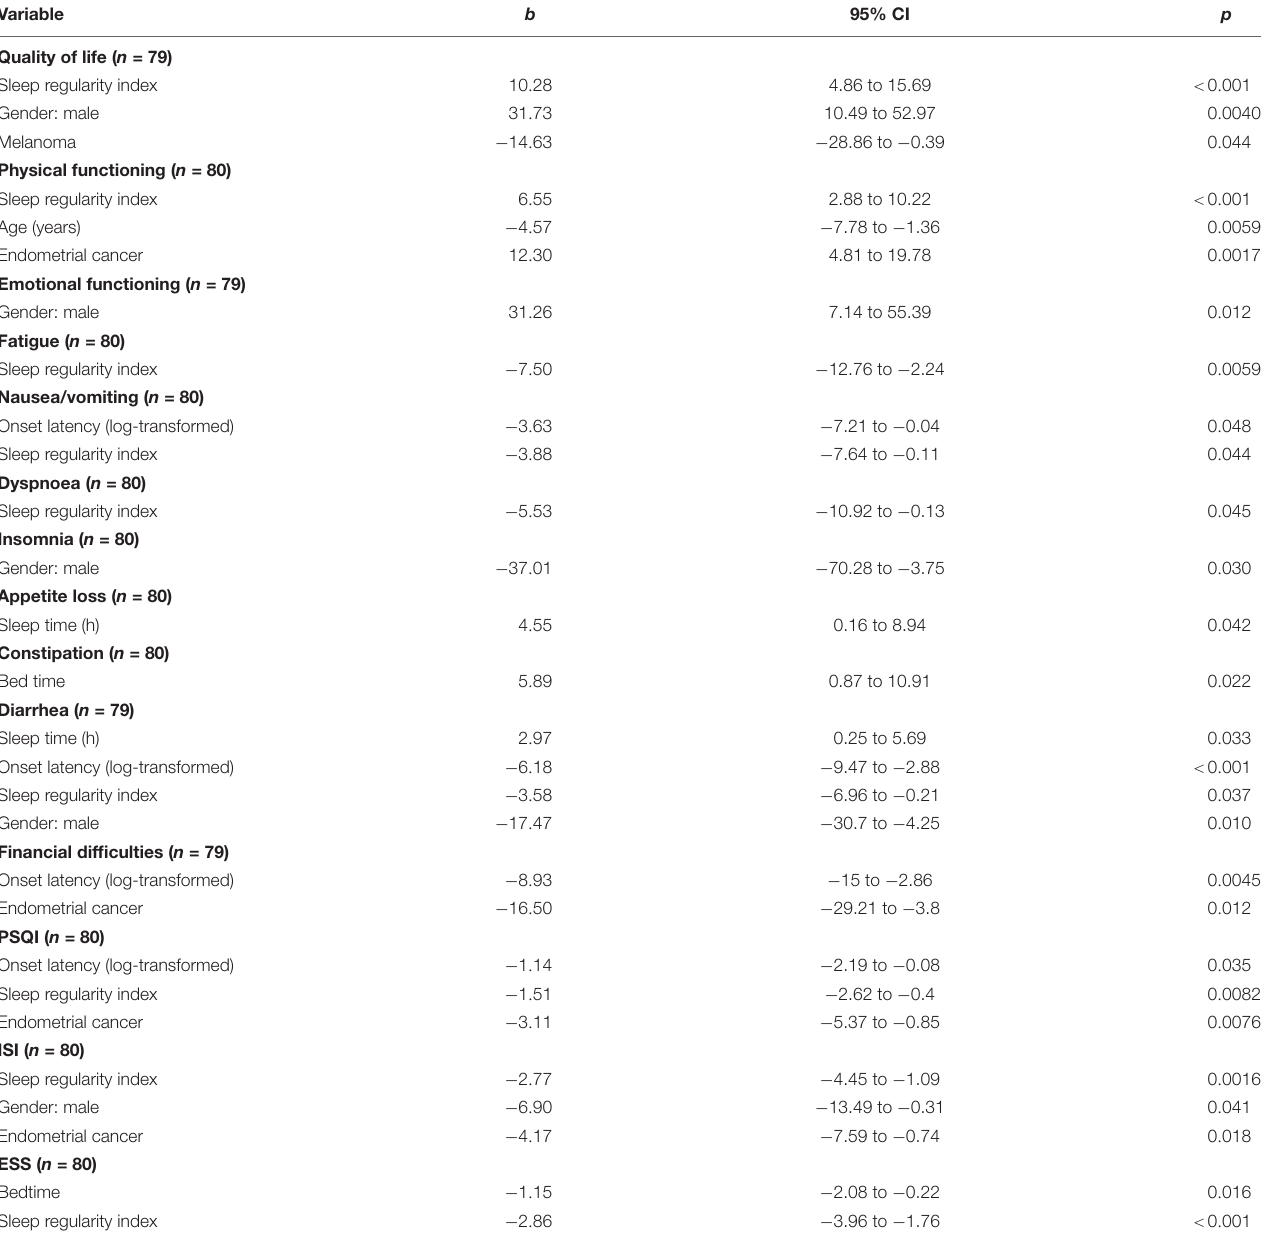
TABLE 3 | Coefficients from linear regression models predicting questionnaire variables [European Organization for Research and Treatment of Cancer Quality of Life Core (EORTC QLQ-C30) quality of life (QoL) scores, functional scores, and symptoms scales; Pittsburgh Sleep Quality Index (PSQI); Insomnia Severity Index (ISI); and Epworth Sleepiness Scale